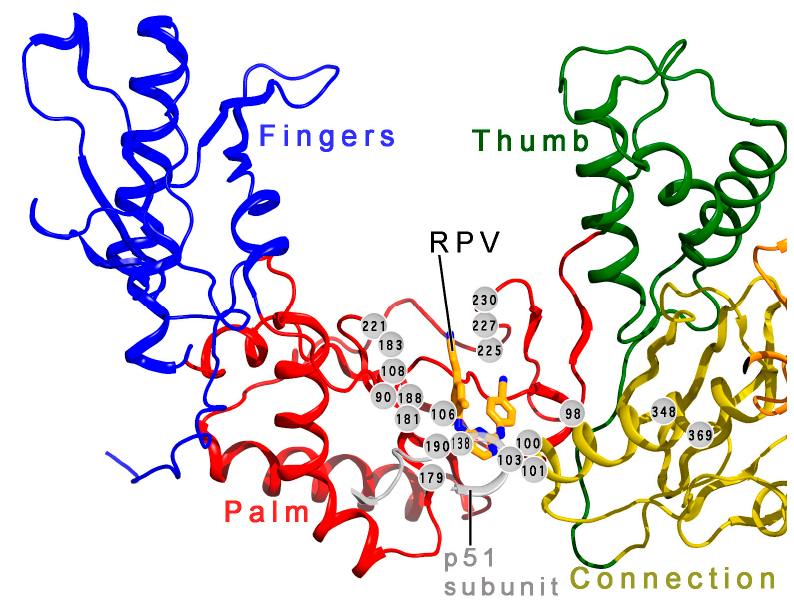
Figure 2. Locations of resistance mutations in RT. The locations of commonly seen NNRTI-resistance mutations (gray orbs with residue numbers) are shown in a ribbon diagram of part of the catalytic p66 subunit of RT and a portion of the p51 subunit. RPV (tan carbon atoms, blue nitrogen atoms) is shown in the NNRTI-binding pocket. Although most resistance mutations occur at or near the binding pocket in the p66 palm subdomain (including at position 138 of the p51 subunit), some mutations are seen in other subdomains of RT and may improve the fitness of drug-resistant variants of RT. The coordinates are taken from the Protein Data Bank (PDB), accession ID 4G1Q [134]. The figure was generated using PyMol®, with annotation in Photoshop®.